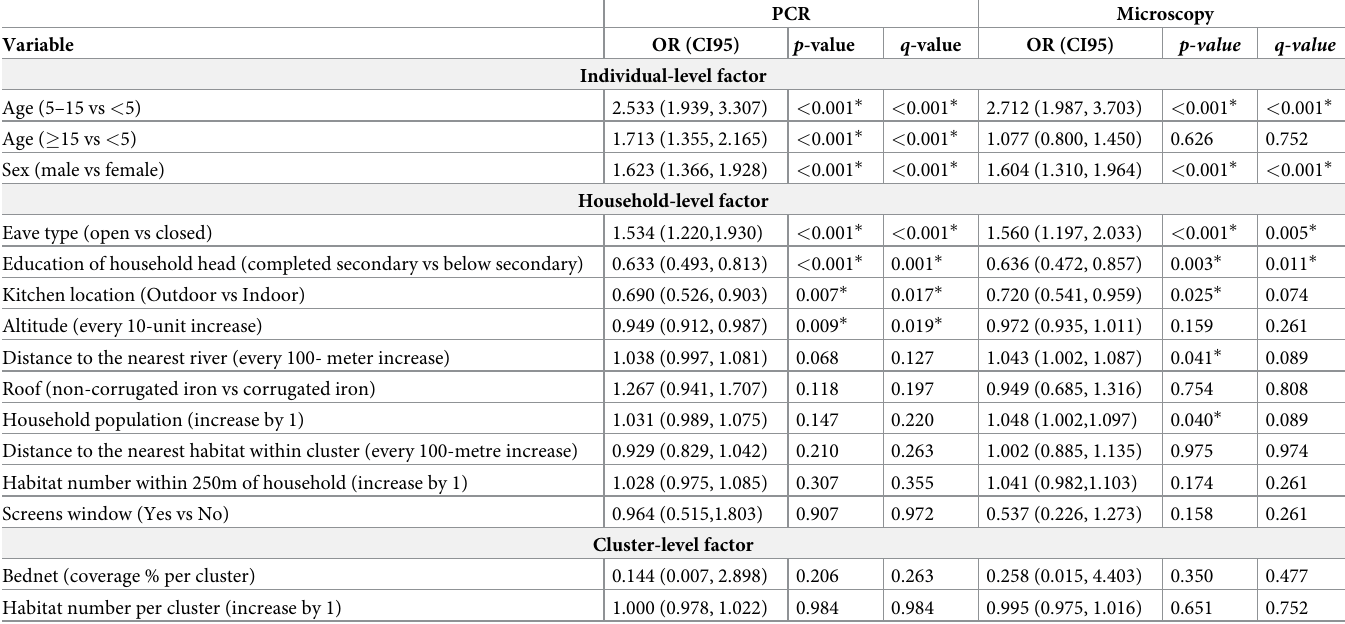
Table 2. Estimated effects of risk factors for P . falciparum infection from